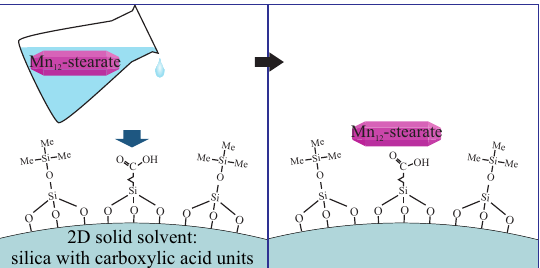
Figure 19. A schematic illustration of the immobilization of the Mn 12 -stearate magnetic molecules by functionalized silica.